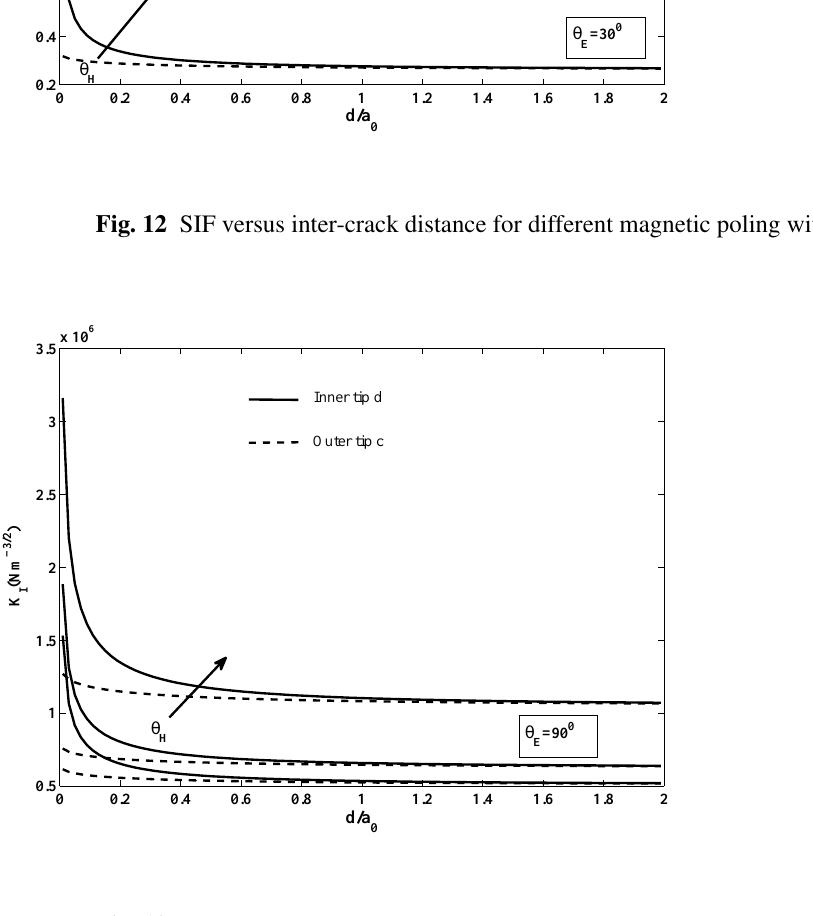
Fig. 13 SIF versus inter-crack distance for different magnetic poling with fixed electric